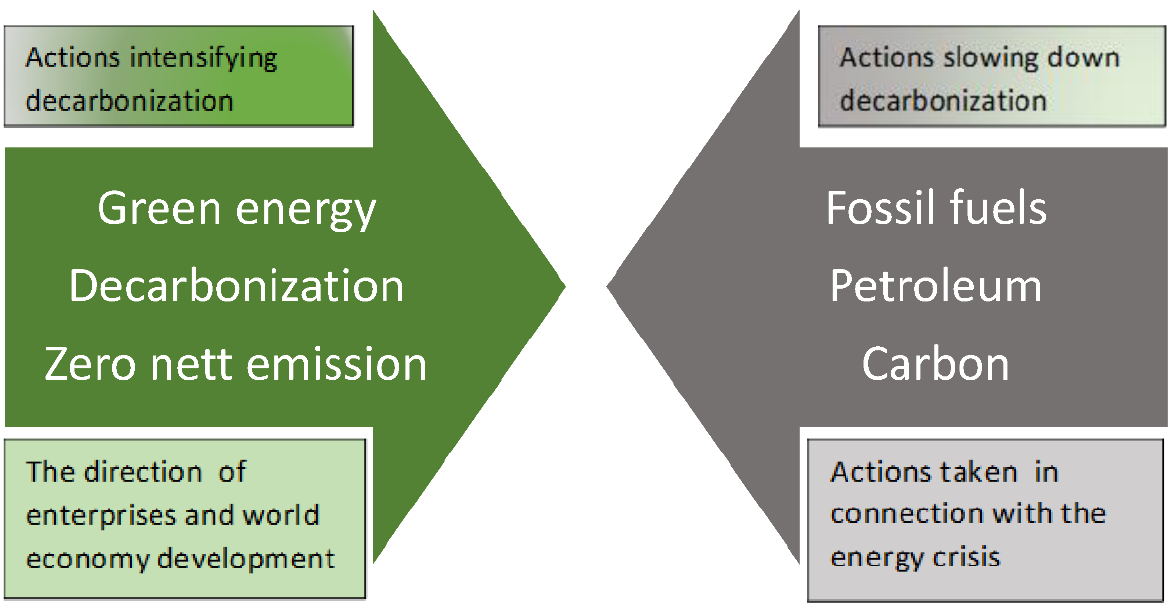
Figure 1. Process of decarbonization vs. energy security in the energy crisis period (own elaboration). The gas crisis caused the European Union (EU) to pay more attention to energy security than to the decarbonization that has been carried out so far. The sharp increase in energy prices and the worrying shortage of natural gas supplies indicate the limited ability to ensure energy security in the European Union. The European Union must now